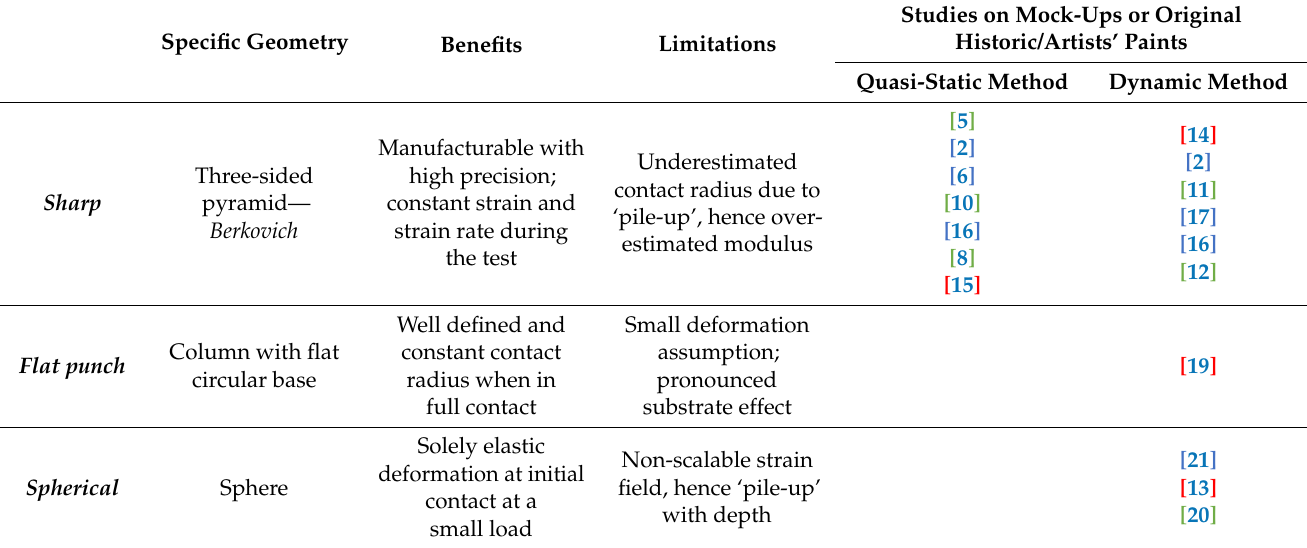
Table 1. Information about probe types and measuring schema applied in nanoindentation studies of artists’ paints (RED—studies of original historic materials; BLUE—studies of mock-ups and model systems; GREEN—treatment/aging studies on